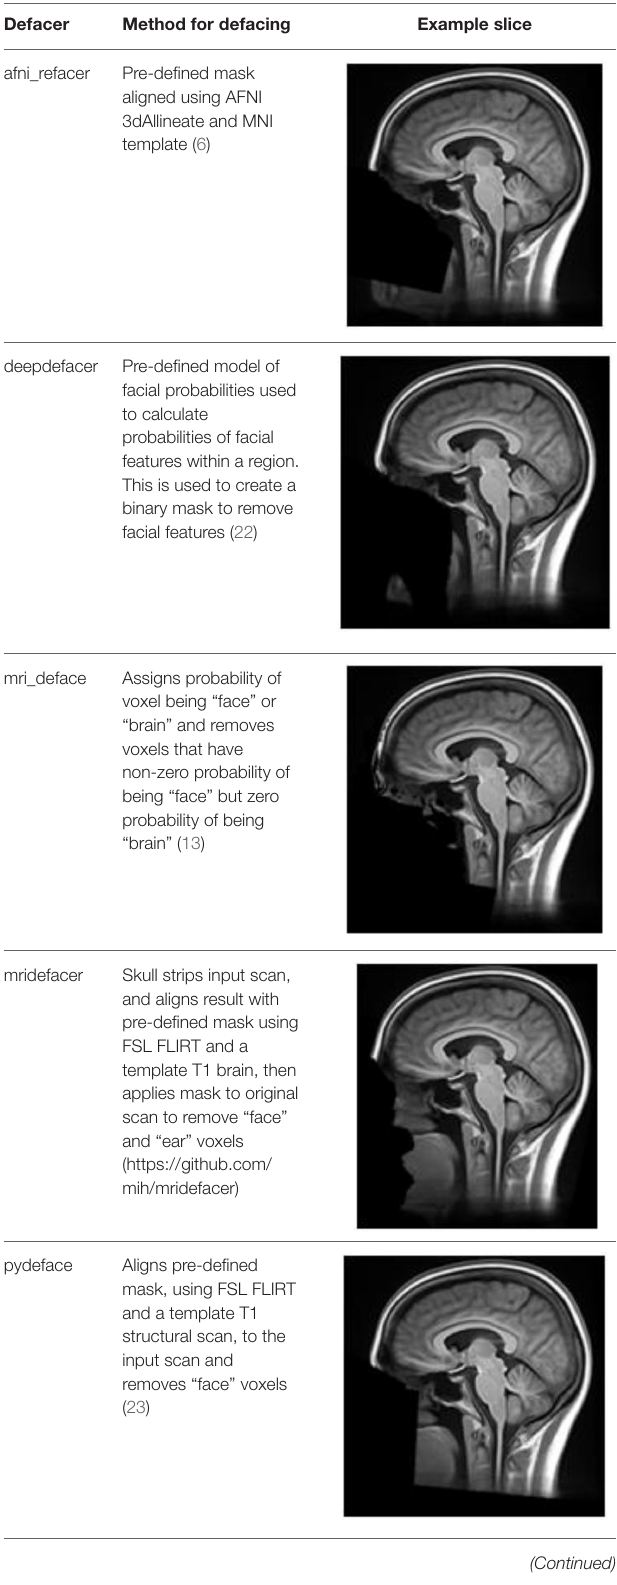
TABLE 2 | Summary of the method used for each algorithm to deface scans, with an example sagittal slice after defacing has been applied.